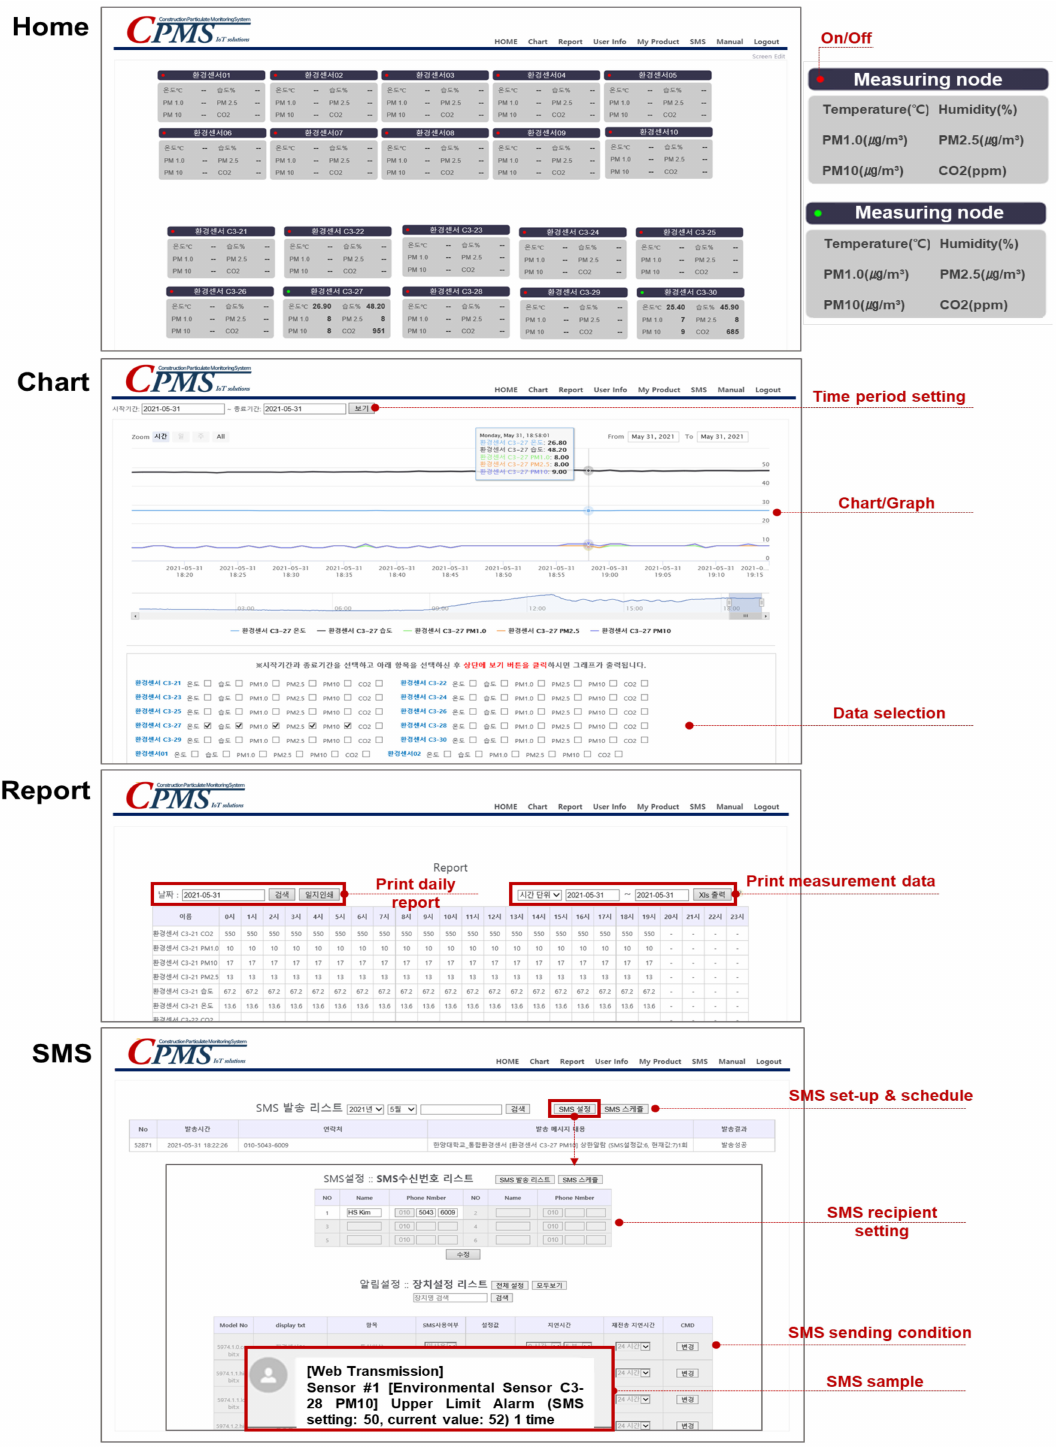
Figure 5. Main screens of the CPMS